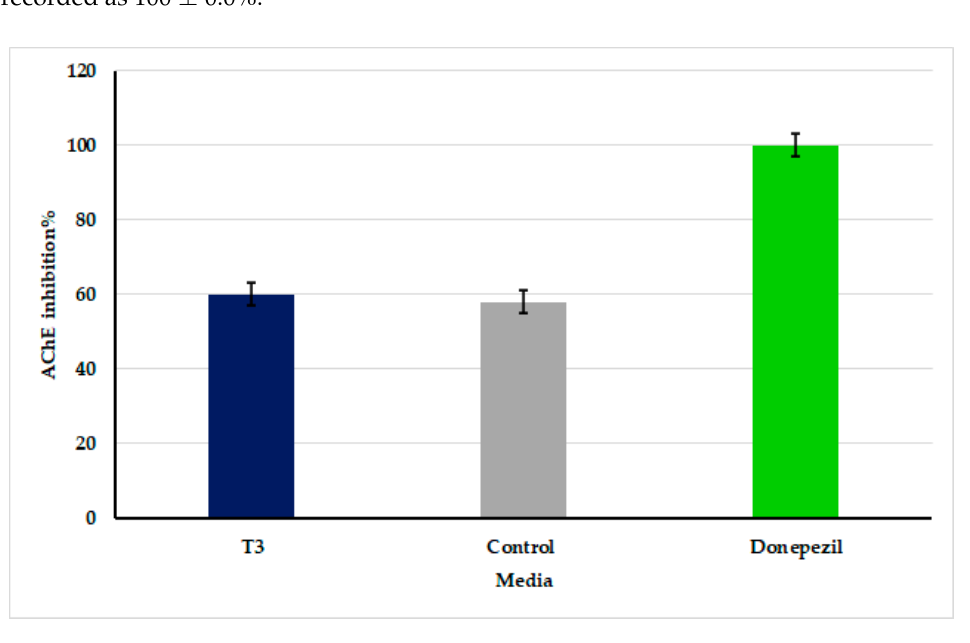
Figure 7. GC chromatogram of O. sancta crude extracts grown on T3.